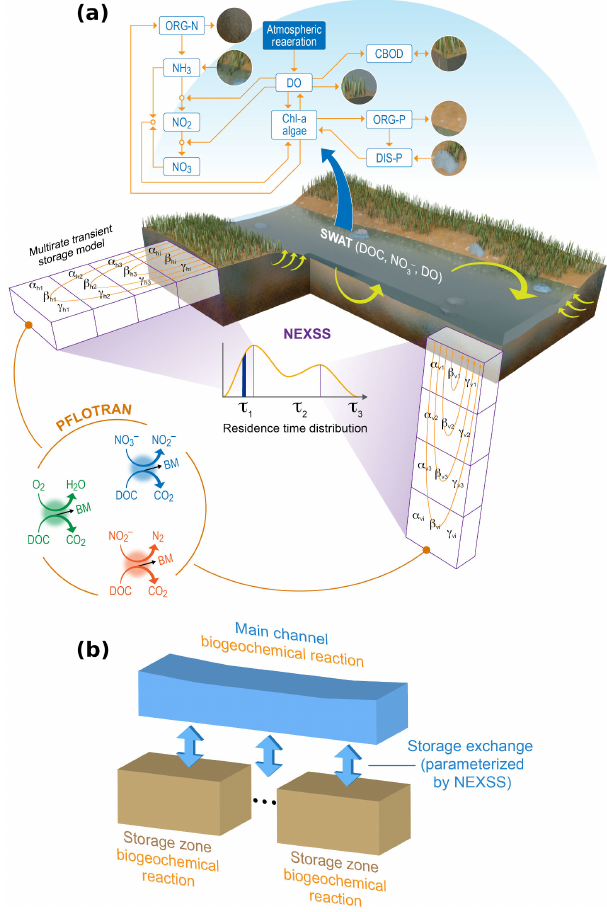
Figure 1. Schematics of coupling SWAT, MRMT, and microbial re- actions in HZs. The top of figure (a) shows reactions in the stream water column. In the circle are representative reactions in the HZs. Rectangular prisms are sub-storage zones. The orange curves in the rectangular prisms are streamlines. Residence time distributions for lateral and vertical HZs are estimated by NEXSS. α i is the exchange rate corresponding to residence time τ i in the sub-storage zone i . β i and γ i represent reaction rates for different reactions in the sub- storage zone i . (b) The simplified conceptual model of (a) . All chemical transformation processes shown are solved using PFLO-